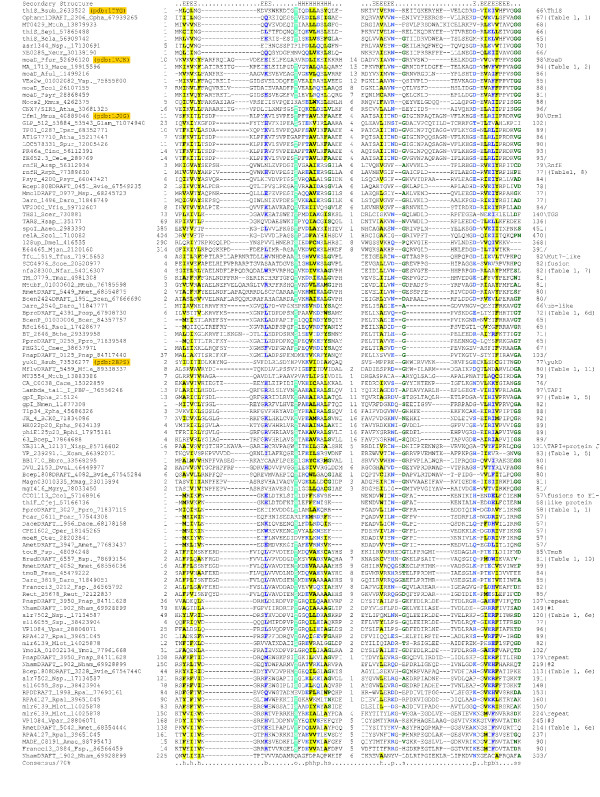
Multiple alignment of ThiS/MoaD-like ubiquitin domain containing proteins. Proteins are listed by gene name, species abbreviation and gi number, separated by underscores. Amino acid residues are colored according to side chain properties and the extent of conservation in the multiple alignment. Coloring is indicative of 70% consensus, which is shown on the last line of the alignment. Consensus similarity designations and coloring scheme are as follows: h, hydrophobic residues (ACFILMVWY), shaded yellow; s, small residues (AGSVCDN), colored green; o, alcohol group containing residues (ST), colored blue; and b, big residues (EFHIKLMQRWY), colored purple and shaded in light gray. Secondary structure assignments are shown above the alignment, where E represents a strand and H represents a helix. The families of the ubiquitin-related domains are shown to the right. Also shown to the right are the row numbers in Table 1, which describe a particular family. Species abbreviations are as follows: Aaeo, Aquifex aeolicus; Adeh, Anaeromyxobacter dehalogenans; Aehr, Alkalilimnicola ehrlichei; Aful, Archaeoglobus fulgidus; Amac, Alteromonas macleodii; Amet, Alkaliphilus metalliredigenes; Asp., Arthrobacter sp.; Azsp, Azoarcus sp.; Atha, Arabidopsis thaliana; Avar, Anabaena variabilis; BJK0, Bacteriophage JK06; Bbro, Bordetella bronchiseptica; Bcen, Burkholderia cenocepacia; Bcep, Burkholderia cepacia; Bcer, Bacillus cereus; Bcla, Bacillus clausii; Blic, Bacillus licheniformis, Bphi, Bacteriophage phiE125; Bsp., Bradyrhizobium sp.; Bsub, Bacillus subtilis; Bthe, Bacteroides thetaiotaomicron; Bthu, Bacillus thuringiensis; Bvie, Burkholderia vietnamiensis; Cace, Clostridium acetobutylicum; Caur, Chloroflexus aurantiacus; Ccol, Campylobacter coli; Cele, Caenorhabditis elegans; Cinc, Chlamydomonas incerta; Cjej, Campylobacter jejuni; Cnec, Cupriavidus necator; Cper, Clostridium perfringens; Cpha, Chlorobium phaeobacteroides; Csac, Caldicellulosiruptor saccharolyticus; Ctet, Clostridium tetani; Dace, Desulfuromonas acetoxidans; Daro, Dechloromonas aromatica; Dhaf, Desulfitobacterium hafniense; Dmel, Drosophila melanogaster; Dpsy, Desulfotalea psychrophila; Drad, Deinococcus radiodurans; Dvul, Desulfovibrio vulgaris; Ecol, Escherichia coli; Elit, Erythrobacter litoralis; Epha, Enterobacteria phage; Fsp., Frankia sp.; Glam, Giardia lamblia; Gmet, Geobacter metallireducens; Goxy, Gluconobacter oxydans; Gsul, Geobacter sulfurreducens; Gura, Geobacter uraniumreducens; Hsap, Homo sapiens; Hsp., Halobacterium sp.; Mace, Methanosarcina acetivorans; Maqu, Marinobacter aquaeolei; Mdeg, Microbulbifer degradans; Mfla, Mycobacterium flavescens, Mgry, Magnetospirillum gryphiswaldense; Mjan, Methanocaldococcus jannaschii; Mlot, Mesorhizobium loti; Mmag, Magnetospirillum magnetotacticum; Mmus, Mus musculus; Msp., Magnetococcus sp.; Mtub, Mycobacterium tuberculosis; Neur, Nitrosomonas europaea; Nfar, Nocardia farcinica; Nham, Nitrobacter hamburgensis; Nisp, Nitrobacter sp.; Nmen, Neisseria meningitidis; Nmul, Nitrosospira multiformis; Noce, Nitrosococcus oceani; Nosp, Nocardioides sp.; Nsp., Nostoc sp.; Nwin, Nitrobacter winogradskyi; Obat, Oceanicola batsensis; PBP-, Phage BP-4795; Paby, Pyrococcus abyssi; Paer, Pseudomonas aeruginosa; Parc, Psychrobacter arcticus; Pber, Parvularcula bermudensis; Pcar, Pelobacter carbinolicus; Pflu, Pseudomonas fluorescens; Pfur, Pyrococcus furiosus; Phor, Pyrococcus horikoshii; Pmen, Pseudomonas mendocina; Pnap, Polaromonas naphthalenivorans; Posp, Polaromonas sp.; Ppro, Pelobacter propionicus; Pput, Pseudomonas putida; Psp., Pseudomonas sp.; Psyr, Pseudomonas syringae; Retl, Rhizobium etli; Reut, Ralstonia eutropha; Rfer, Rhodoferax ferrireducens; Rmet, Ralstonia metallidurans; Rosp, Roseovarius sp.; Rpal, Rhodopseudomonas palustris; Rsol, Ralstonia solanacearum; RhNGR234a, Rhizobium sp. NGR234a plasmid; Rsp, Rhizobium sp. NGR234; Rsph, Rhodobacter sphaeroides; Rusp, Ruegeria sp.; Rxyl, Rubrobacter xylanophilus; Saci, Syntrophus aciditrophicus; Save, Streptomyces avermitilis; Scer, Saccharomyces cerevisiae; Scoe, Streptomyces coelicolor; Sdis, Spisula solidissima; Sepi, Staphylococcus epidermidis; Spom, Schizosaccharomyces pombe; Spur, Strongylocentrotus purpuratus; Srub, Salinibacter ruber; Ssol, Sulfolobus solfataricus; Ssp., Synechocystis sp.; Swsp, Shewanella sp.; Tfus, Thermobifida fusca; Tmar, Thermotoga maritima; Tpar, Theileria parva; Vcho, Vibrio cholerae; Vfis, Vibrio fischeri; Vpar, Vibrio parahaemolyticus; Vsp., Vibrio sp.; Wsuc, Wolinella succinogenes; Xaxo, Xanthomonas axonopodis; Xcam, Xanthomonas campestris; Ymol, Yersinia mollaretii; Ypes, Yersinia pestis.